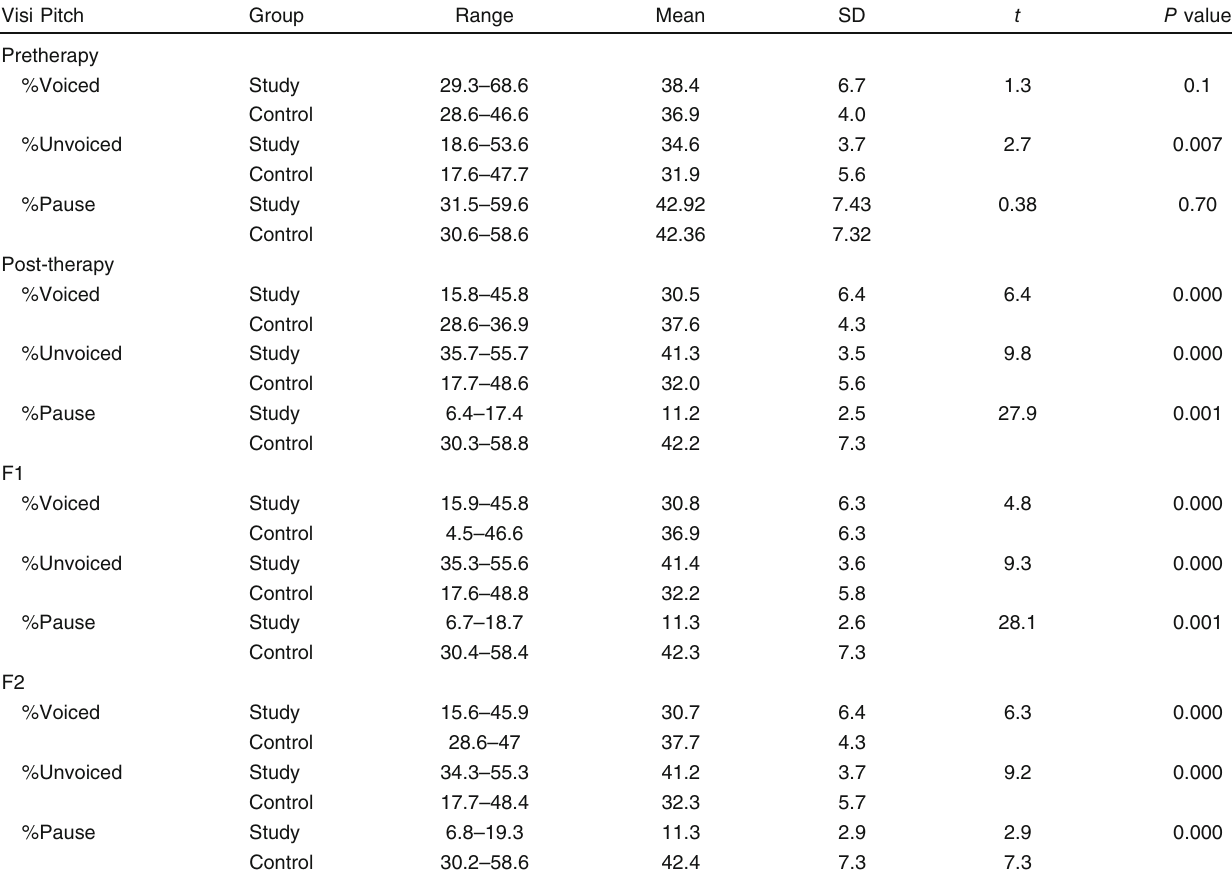
Table 10 Comparison between the study group and the control group as regards Visi